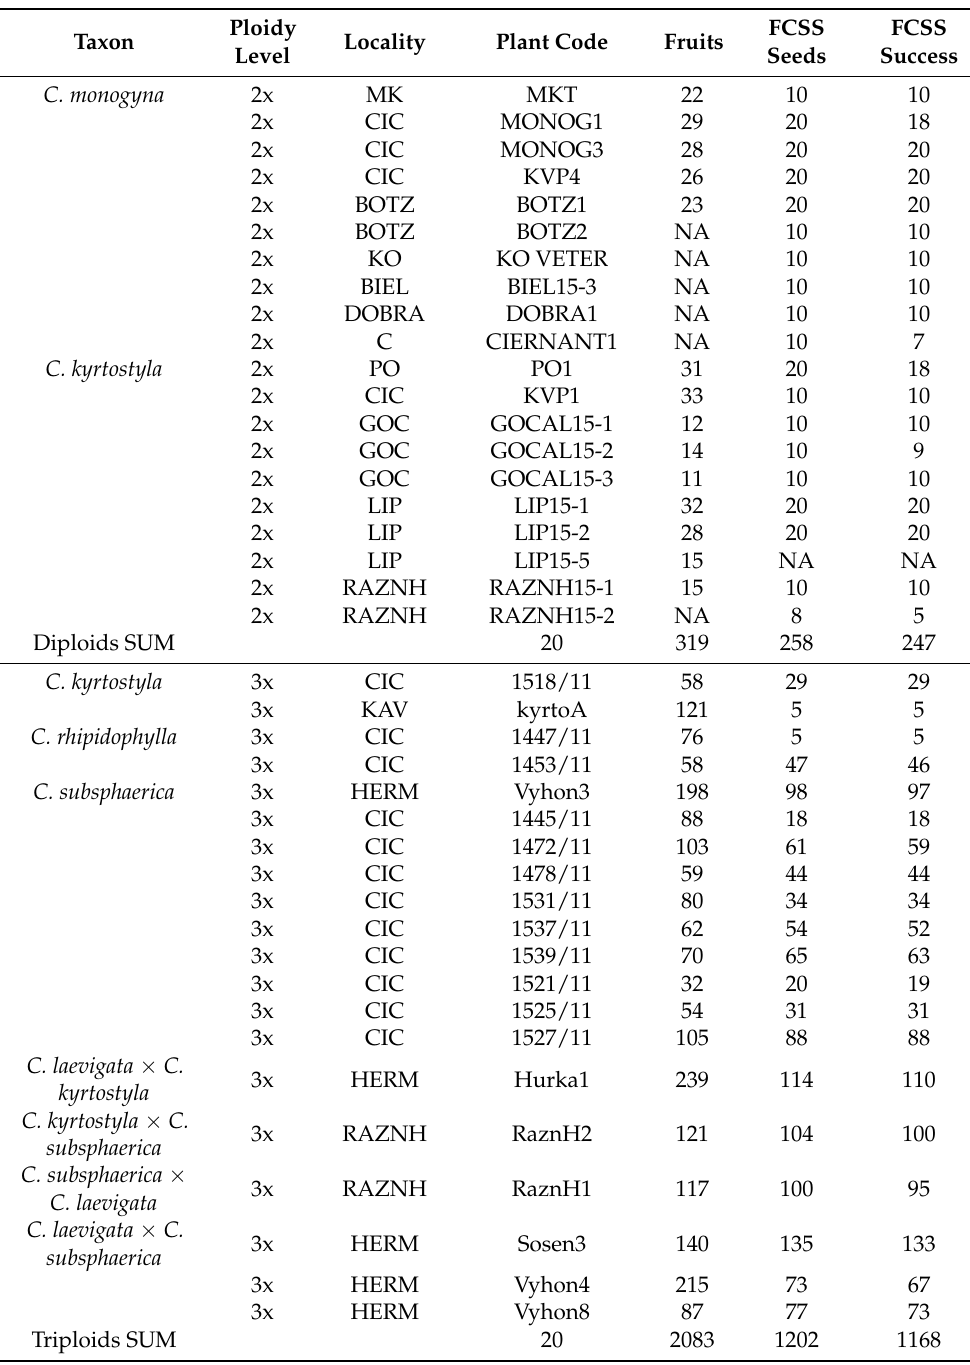
Table 2. Survey of plant material of the genus Crataegus used in the study. Taxonomic assignment to a particular species and hybrids is given in the Taxon column; the inferred ploidy level, in the Ploidy level column; the source population, in the Locality column; and particular accessions, in the Plant code column. The sample size used in analyses is provided for fruits precisely investigated for successful development of seeds ( Fruits ), seeds analyzed for the FCSS ( FCSS seeds ), with successful determinations of both embryo and endosperm ploidy level ( FCSS success ). NA—not applied. Those plants marked with asterisks indicate the individuals with indirectly determined ploidy level— inferred from the ploidy level of their